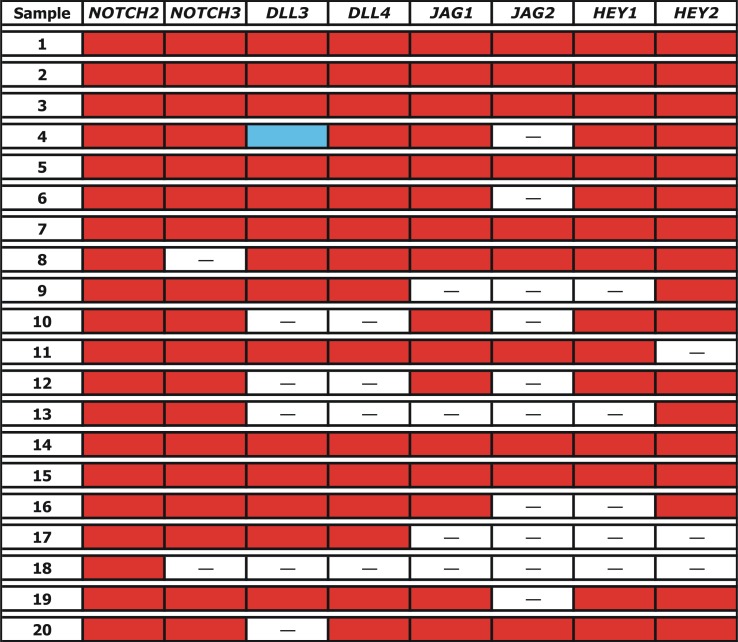
Schematic representation of Notch pathway molecules mRNA expression profile in our series of preeclampsia-complicated late preterm and term placentas.Red: Downregulation; White: Normal expression; Sky Blue: Overexpression.